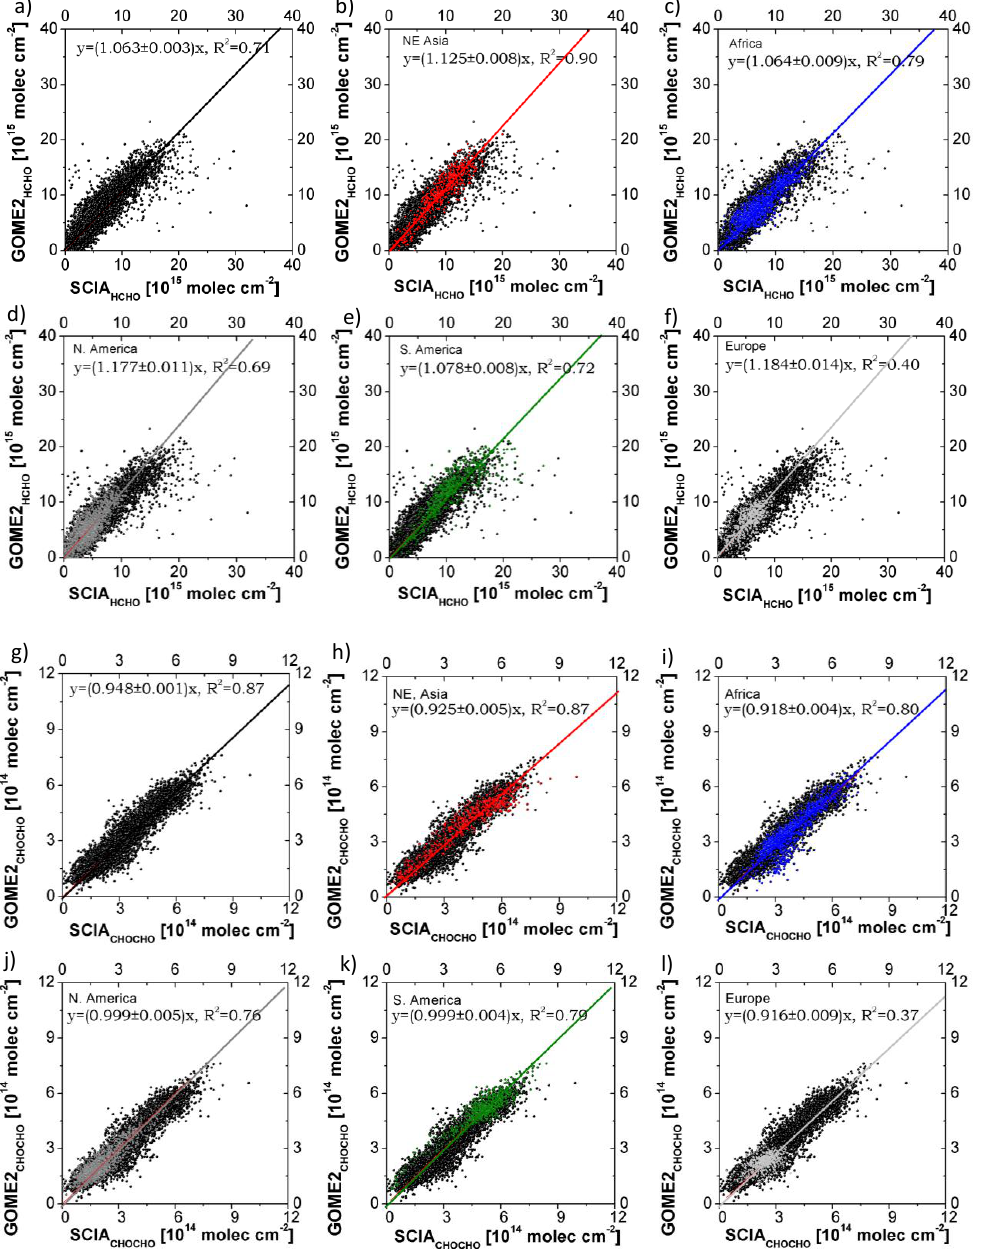
Figure 2 : Comparison between GOME-2 and SCIAMACHY retrieved VCD HCHO (Fig. 2a) and VCD HCHO (Fig. 2g) for the period 2007-2008 based on land data gridded at [1 o x1 o ] in the latitudinal range of 20°S to 55°N and excluding data over deserts as these are sometimes affected by retrieval artifacts. The black line depicts the linear fit regression line for the entire dataset. In addition, the correlation of the retrieved VCD HCHO and VCD CHOCHO over northeastern Asia (Fig. 2b and h, red colour), Africa (Fig. 2c and 2i, blue colour), N. America (Fig. 2d and j, grey colour), S. America (Fig. 2e and 2k, green) and Europe (Fig. 2f and 2l, light grey colour) are shown. Linear fit regression lines are also plotted with the corresponding color.